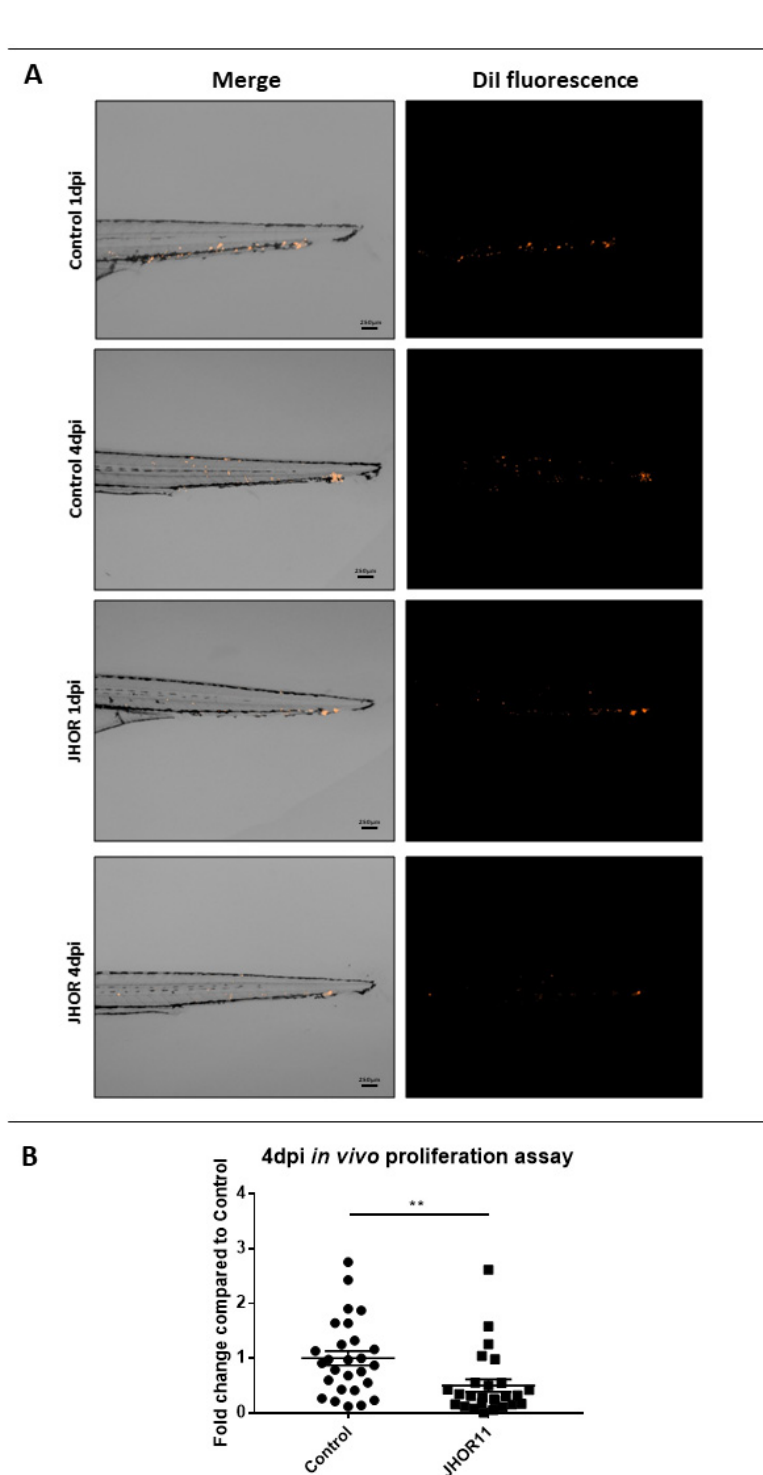
Figure 15. In vivo xenograft assays of human HCT116 colorectal cancer cell line with the JHOR11 (JHOR) treatment. ( A ) Representative images of the tail region of the zebrafish embryos (caudal hematopoietic tissue—CHT) where the DiI HCT116 labelled cells metastasize and proliferate at 1 dpi and 4 dpi for comparison. Main images are a superposition of a fluorescence image and a bright field image of the same embryo. Fluorescence images shows only the labelled cells of the main image. Scale = 250 µ m. ( B ) Proliferation analysis based on the images taken at 4 dpi compared with the ones at 1 dpi, representing the fold change normalized to the control condition (n total = 25 embryos/condition, 3 replicates). (** p value =